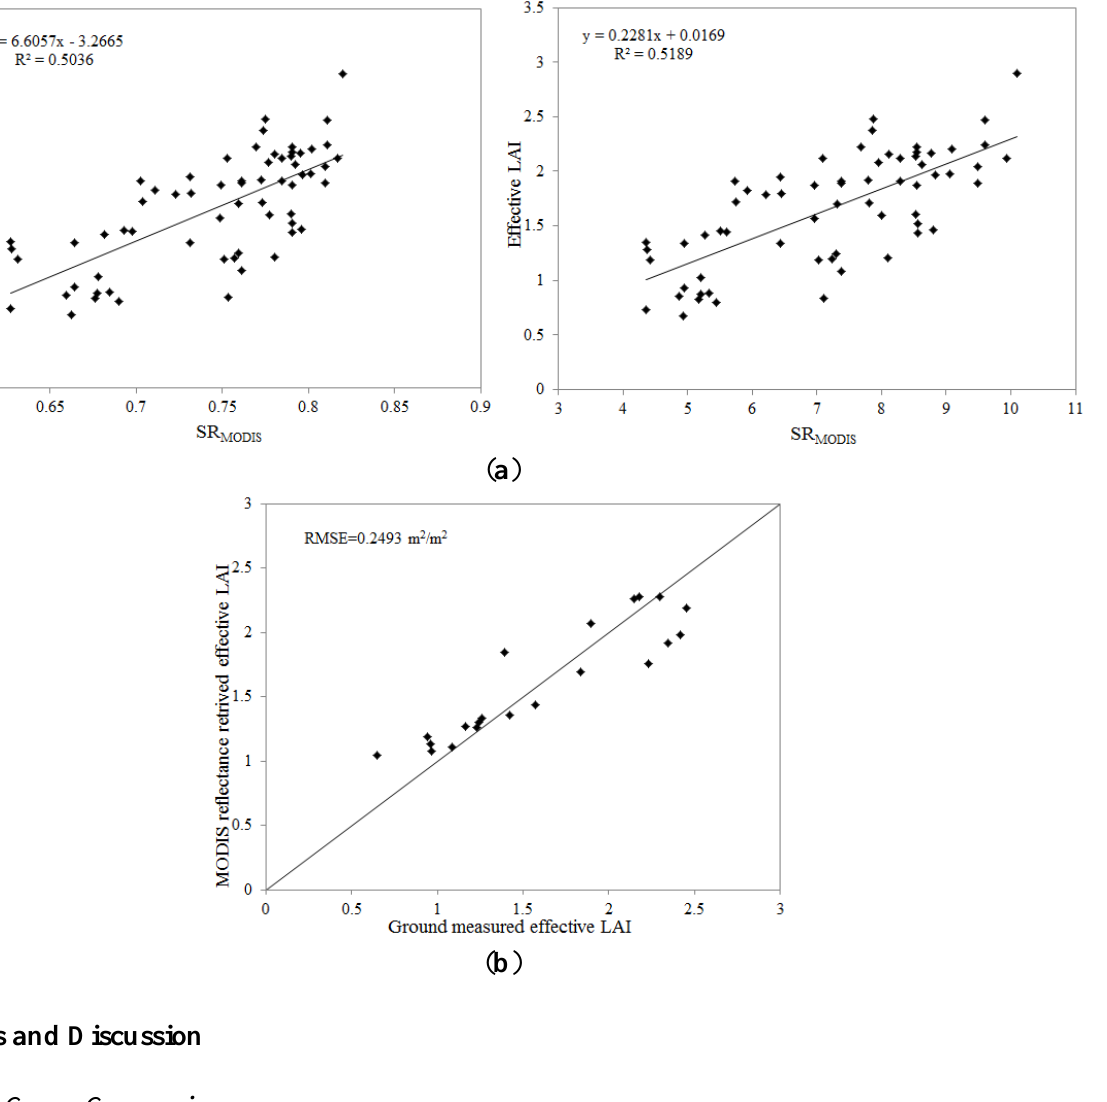
Figure 6. Relationships between ground effective LAI and MODIS reflectance generated vegetation indices, and validation of retrieved LAI maps. ( a ) Relationships between ground effective LAI and NDVI ( left ) and LAI-SR ( right ). ( b ) Validation of retrieved MODIS MODIS LAI maps derived from LAI-SR MODIS